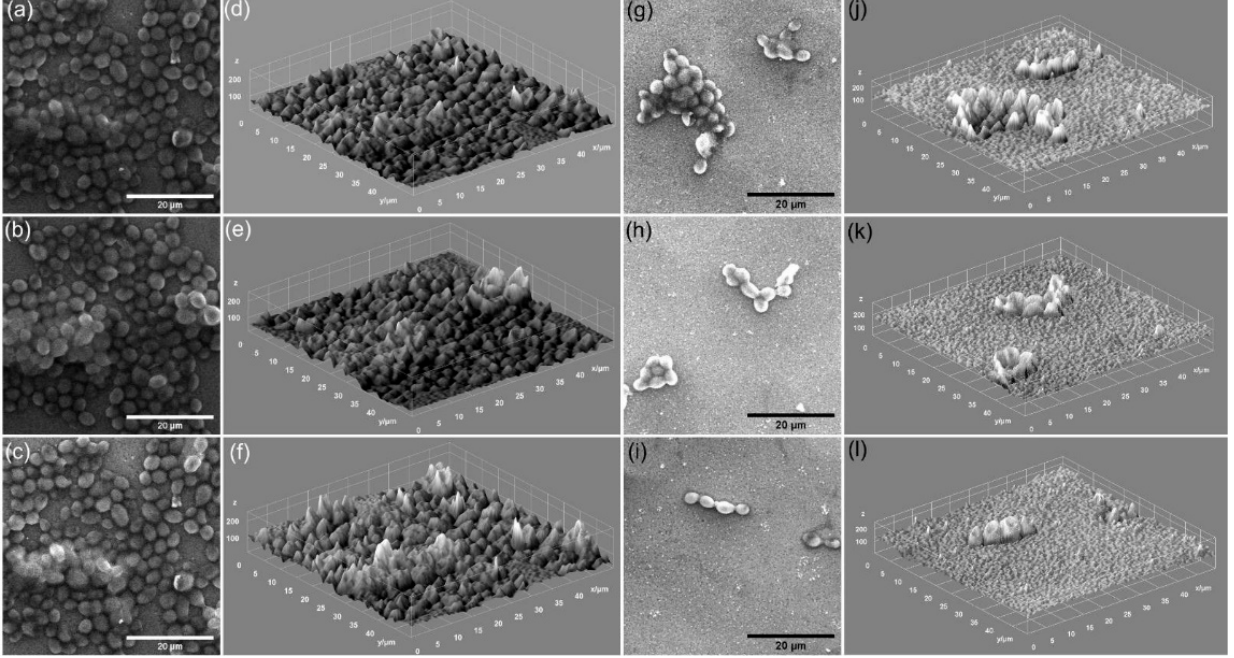
Figure 9. 2D SEM images and 3D representation of Candida albicans ATCC 10231 cell development on HAp ( a − f ) and 5EuHAp ( g − l ) coatings deposited on Si after 24 h ( a , d , g , j ) 48 h ( b , e , h , k ), and 72 h ( c , f , i , l ) of